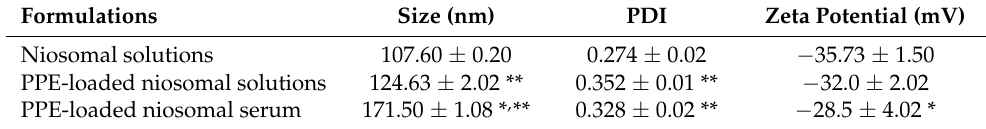
Table 1. Characterization of niosomal solution and niosomal serum containing 1000 µ g/mL PPE.